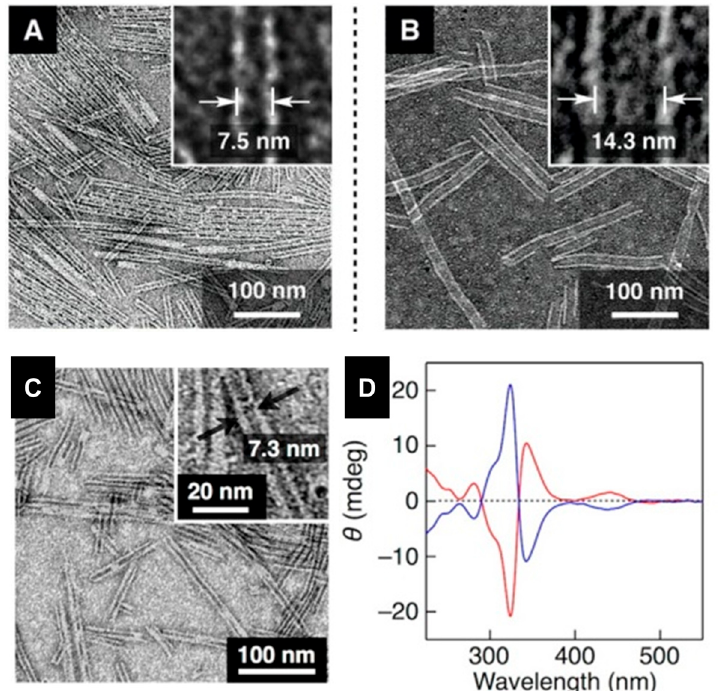
Figure 14. TEM micrographs of air-dried MeCN/water dispersions of: ( A ) 16 ; ( B ) 17 ; ( C ) CD active NT formed by 16 in presence of (+/ − )-MS; and ( D ) CD spectrum of NTs obtained using (+)-MS (red line) and ( − )-MS (blue line). Partially reproduced with permission from Ref. [60] (Copyright the American Association for the Advancement of Science, 2014) and [61] (Copyright the American Chemical Society, 2015).